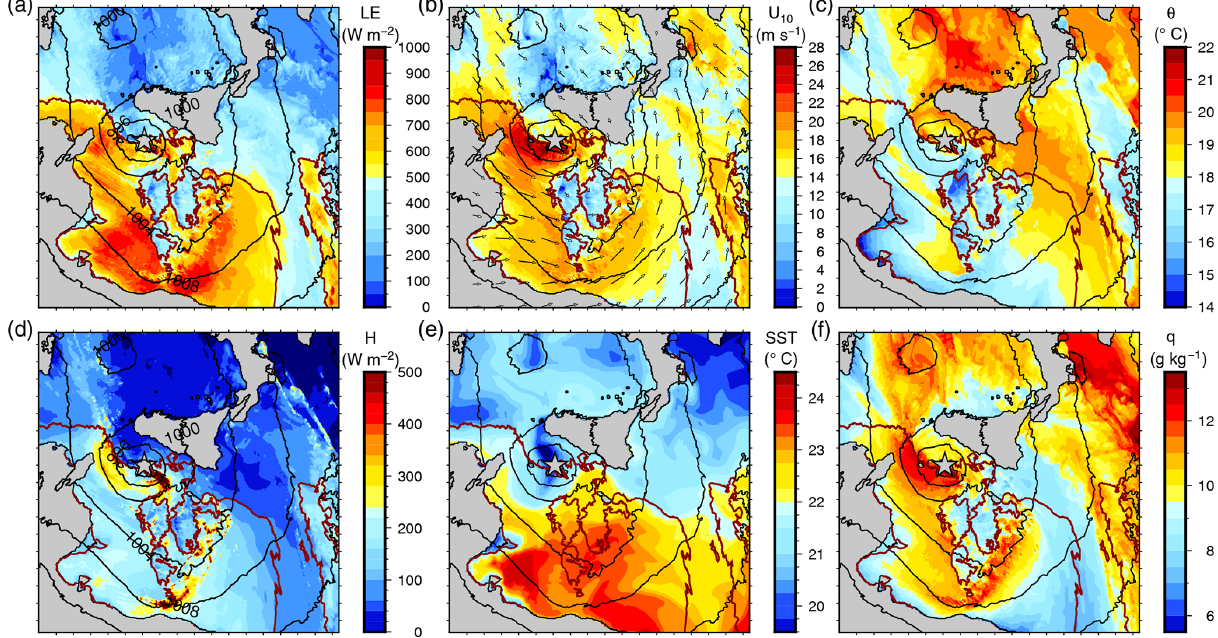
Figure 13. Maps of the turbulent heat fluxes LE (a) , H (d) , 10m wind U 10 (b) , 10m potential temperature (c) , SST (e) and specific humidity at 2m (f) at 09:00UTC on 7 November in the CPL simulation.